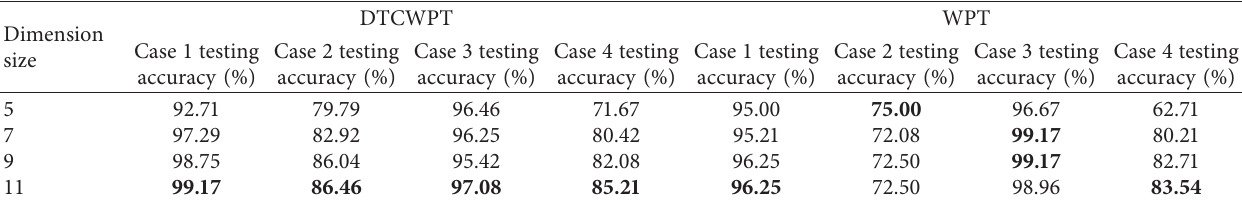
Table 9: Bearing fault diagnosis results obtained by OFS-MMC-SVM.